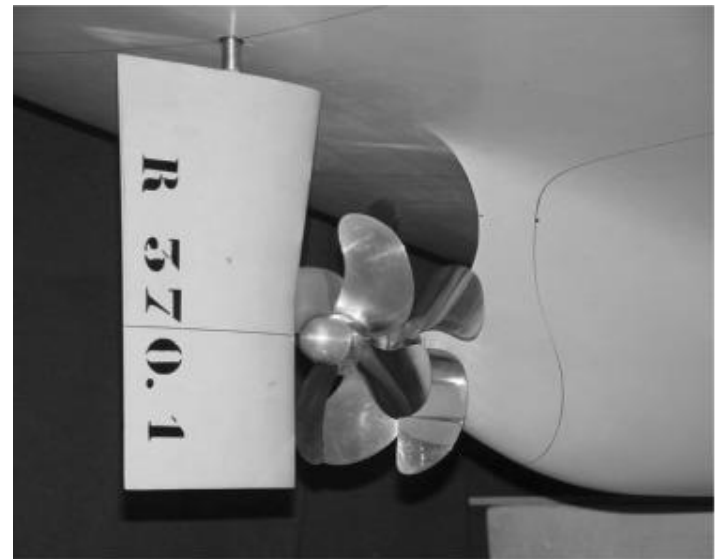
Figure 1. The CRP system at the stern of the model ship [22].